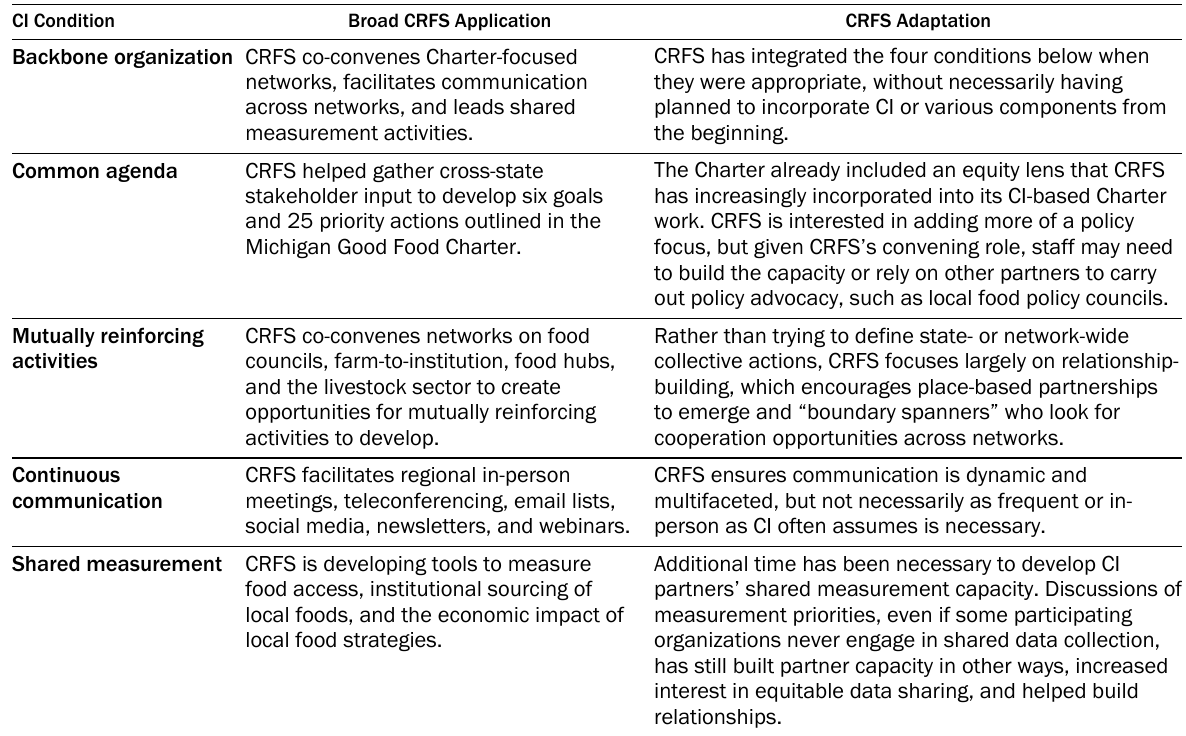
Table 1. Summary of CRFS Application and Adaptation of Collective Impact (CI) CI